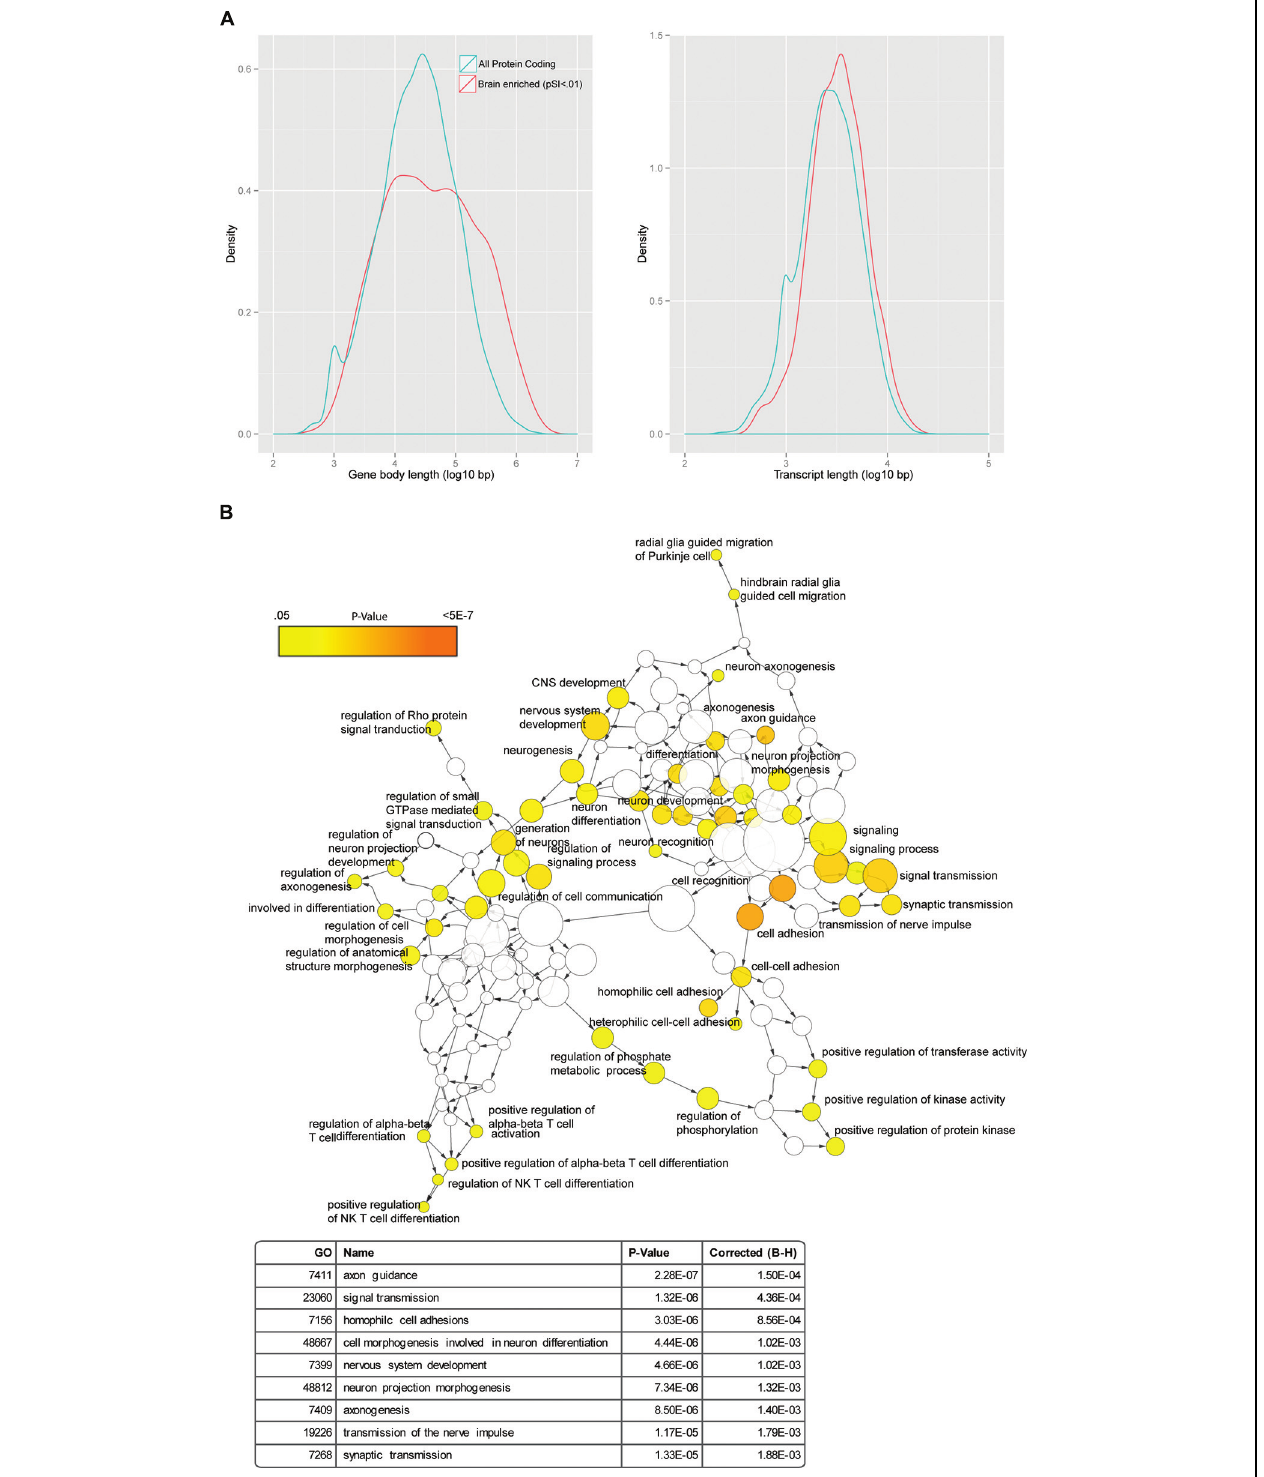
FIGURE 1 | Genes with enriched expression in the brain are long. (A) Genes with enriched expression in the brain are longer both as mature transcripts (right) and in terms of gene body length (left), when compared to protein coding genes as a whole. (B) Random GWAS results show enrichment in a network of brain-related GO terms: using a uniform distribution between 0 and 1, random p -values were assigned to SNPs in the genome, and SNPs were mapped to genes using ANNOVAR. The SNP with the lowest p -value in a gene was used to determine the 500 most significant genes that were then used for a GO analysis and displayed as a network using BINGO. Dozens of categories related to CNS function were significant (examples shown in table at bottom).